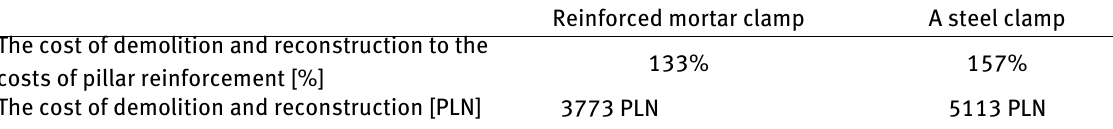
Table 3: Values for the criterion: the ratio of demolition and reconstruction costs to pillar reinforcement costs (own studies)